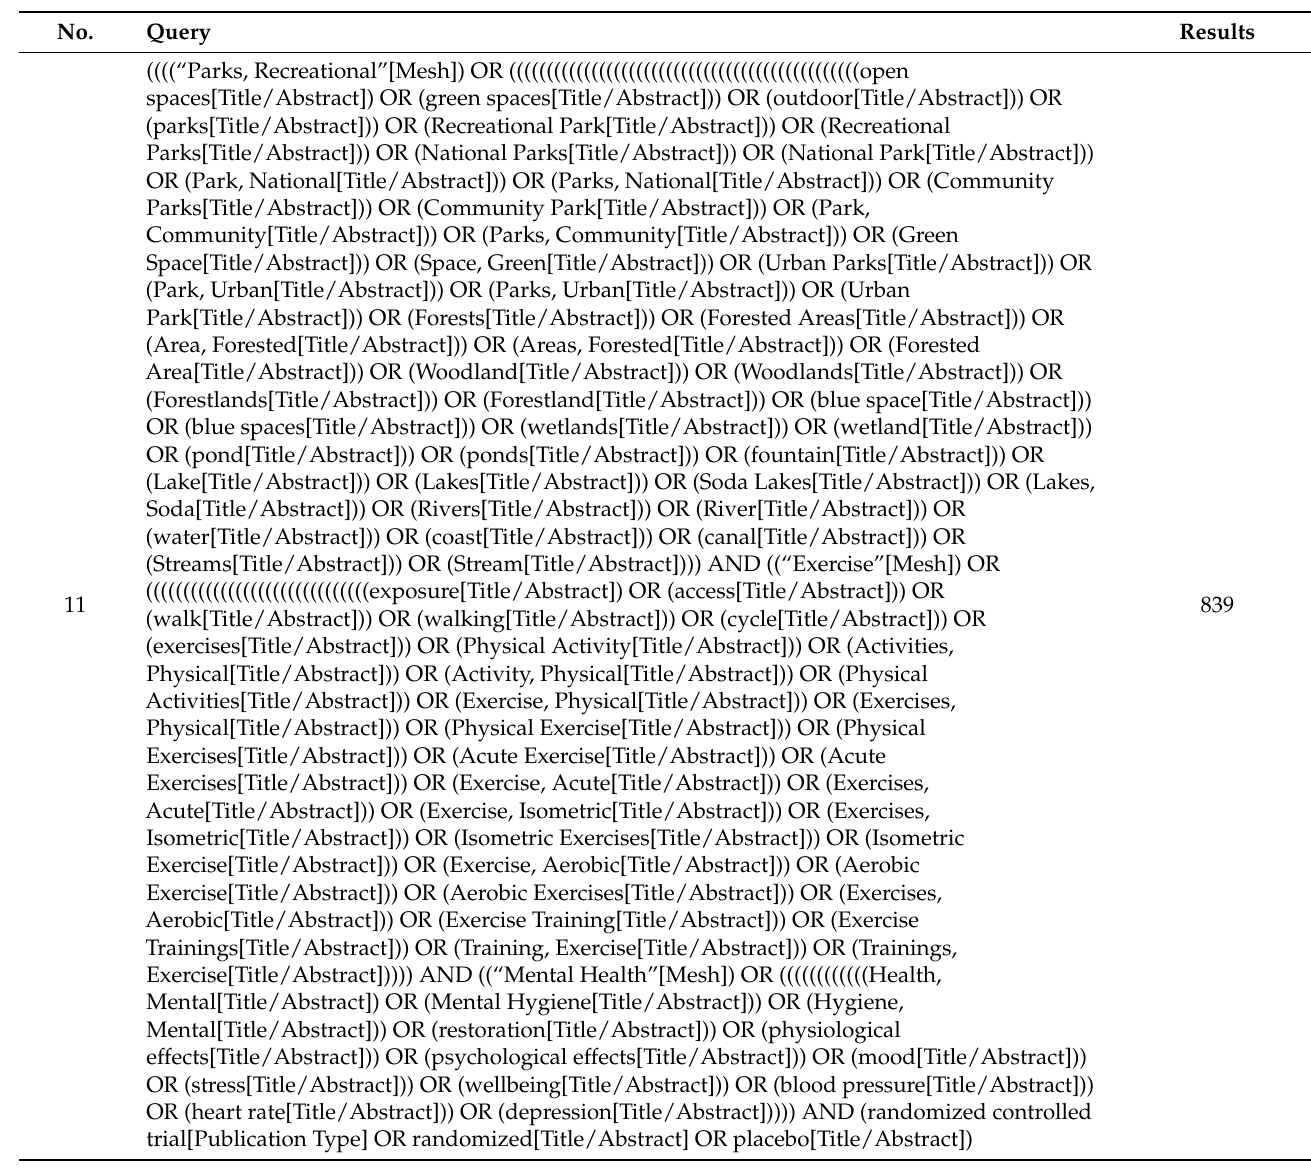
Table A1. Search content used for systematic search on evidence for the restorative benefits of exposure to green spaces on PubMed database (updated on 6 December